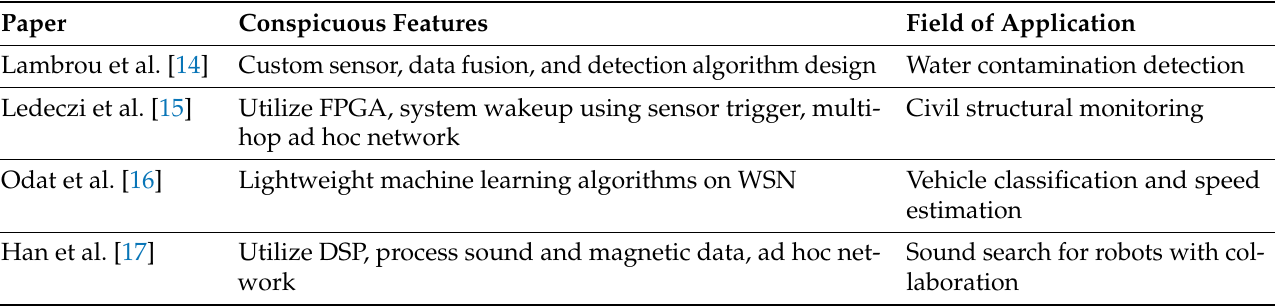
Table 1. Heterogeneous sensor systems with system design features.